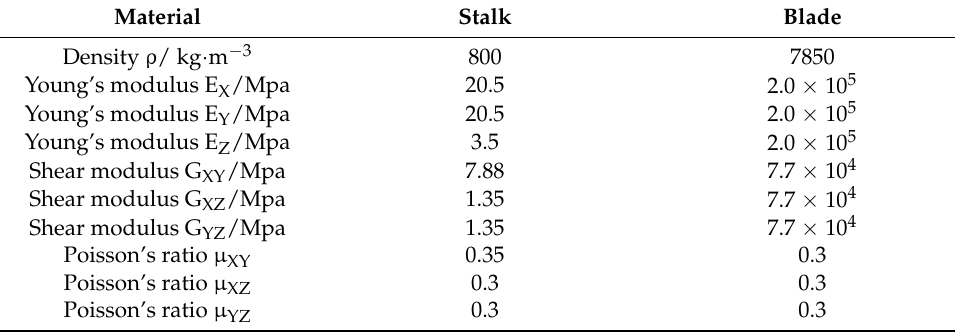
Table 2. Main material parameters of the geometric model.